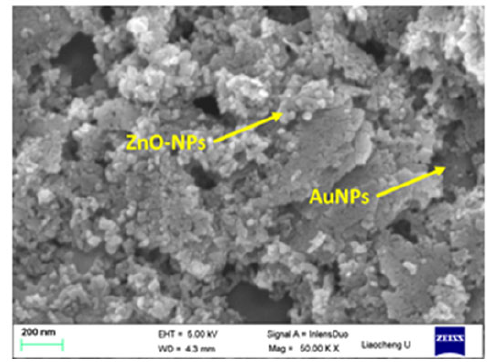
Fig. 11 SEM image of Probe II, gold, and zinc oxide nanoparticles over the surface of the taper fiber